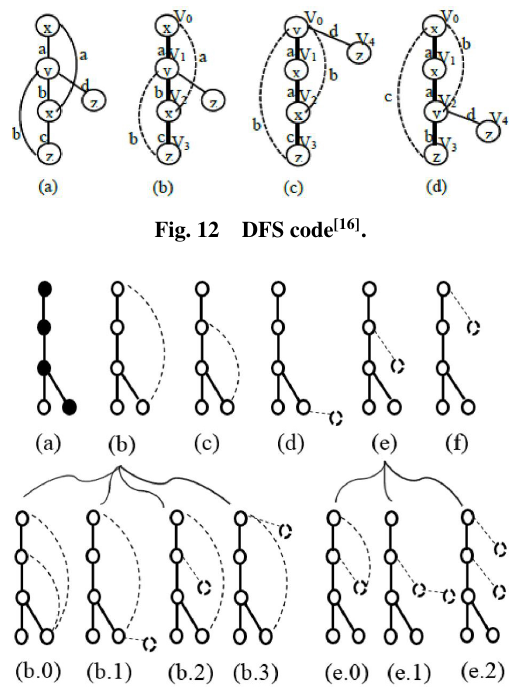
Fig. 13 Rightmost expansion [16]